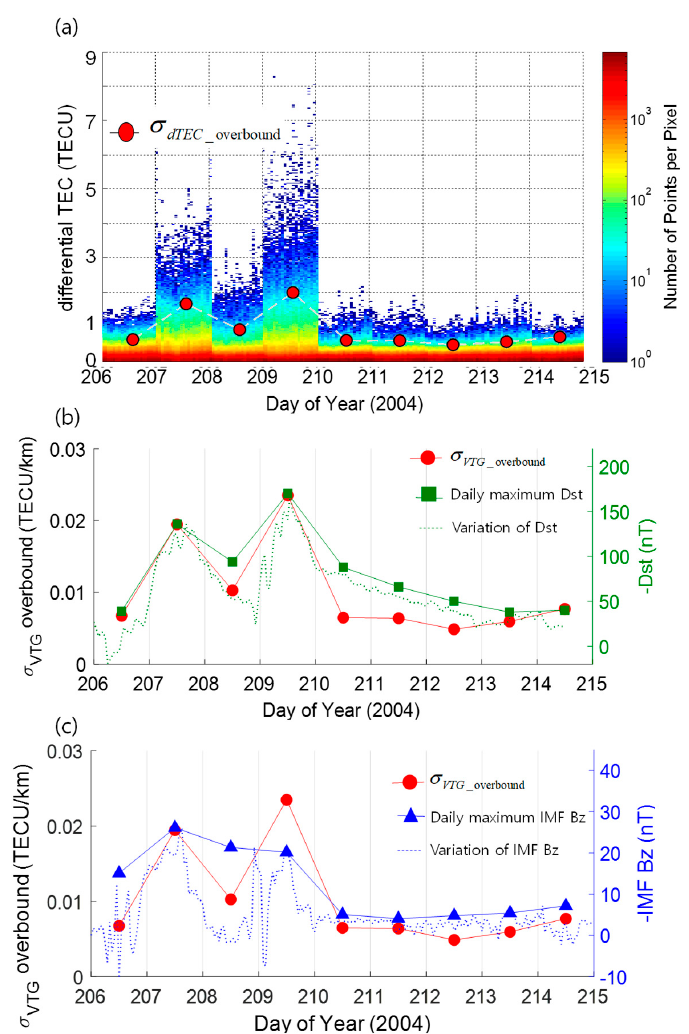
Figure 4. A series of a histogram of differential TEC in 2004 in ( a ), and variations of σ VTG_overbound and corresponding daily and hourly maxima of negative disturbance storm time (Dst) ( b ), and negative interplanetary magnetic field (IMF) Bz ( c ), respectively.